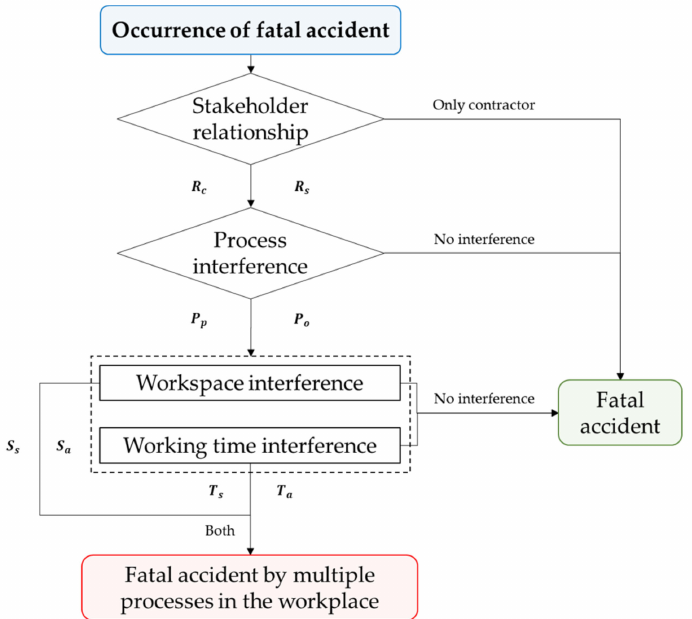
Figure 3. Procedures to determine accidents caused by multiple processes in the